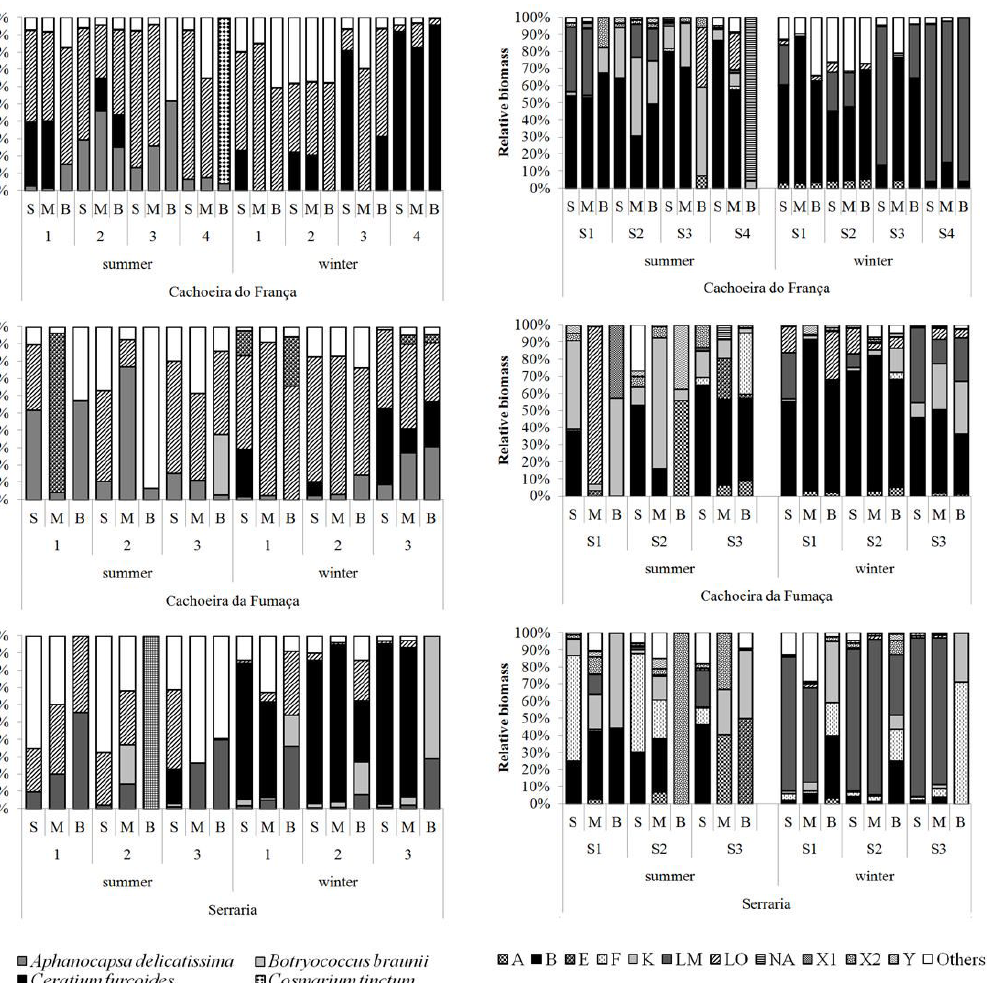
Figure 4. Phytoplankton codons relative biomass (%) in the three strata (S subsurface, M middle, B bottom layers) and sampling sites (S1, S2, S3, S4) during the winter and summer at the three cascading